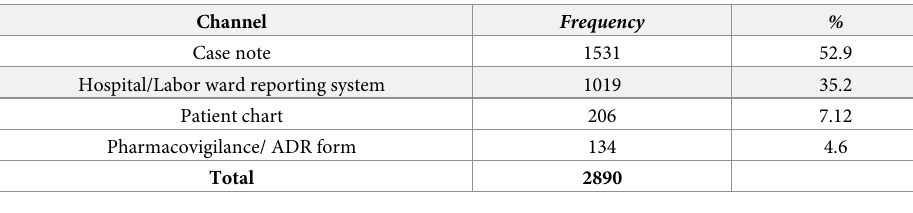
Table 9. Respondents’ � action following suspected poor quality or perceived ineffectiveness of oxytocin when encountered. Action taken Frequency % Tell supervisor/administrator 4896 61.6 Document it in writing 2737 34.5 Do nothing 310 3.9 Total 7943 � Multiple response question.